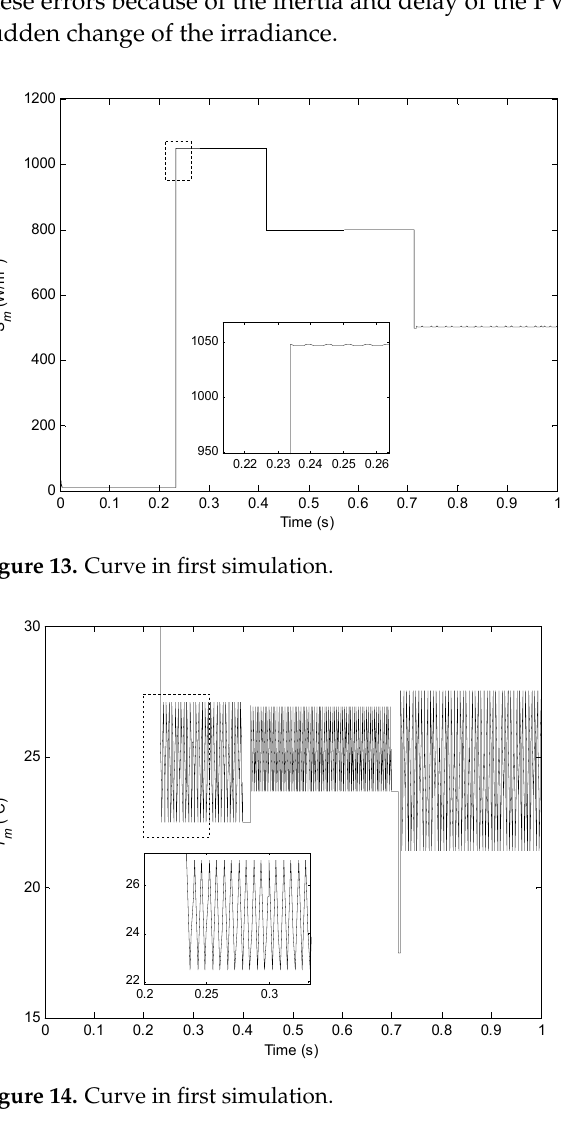
Figure 14. Curve in first simulation.